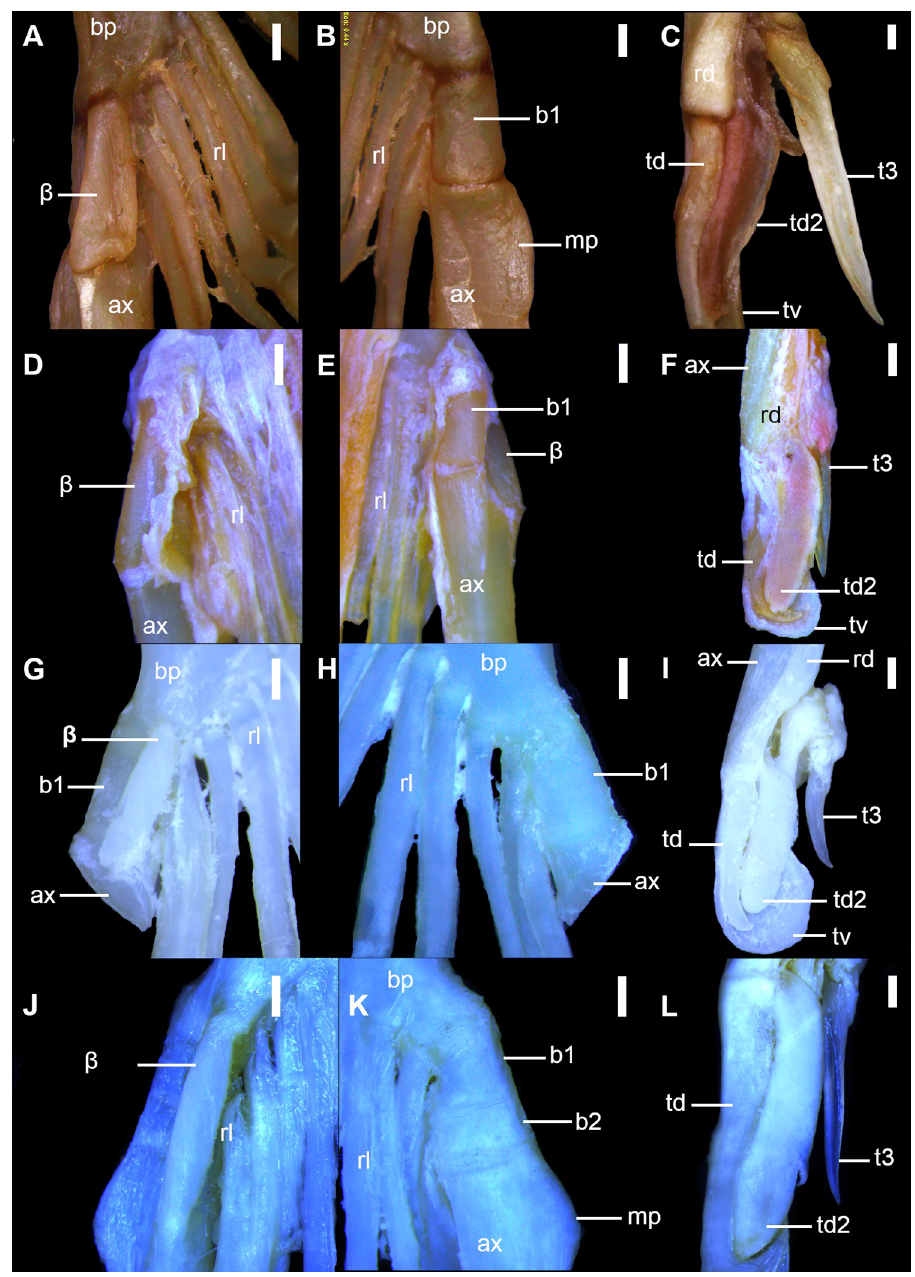
Fig 9. Detail of cartilages of the clasper in Squalus species in dorsal (A,D,G,J), ventral (B,E,H,K) and terminal dorsal (C,F,I,L) views. A–C: S . acanthias , SAM 38276, adult male, 670mmTL; D–F: S . brevirostris , HUMZ 189762, adult male, 433 mm TL; G–I: S . albifrons , MZUSP 121272, adult male, 760 mm TL; J–L: S . montalbani , MZUSP121270, adult male, 713 mm TL. Abbreviations: ax: axial cartilage; bp: basipterygium; b1: first intermediate segment; b2: second intermediate segment; mp: mesial process; rd: dorsal marginal cartilage; rl: pelvic radials; td: dorsal terminal cartilage; td2: dorsal terminal 2 cartilage; tv: ventral terminal cartilage; t3: accessory terminal 3 cartilage; β : beta cartilage. Scale bars: 1